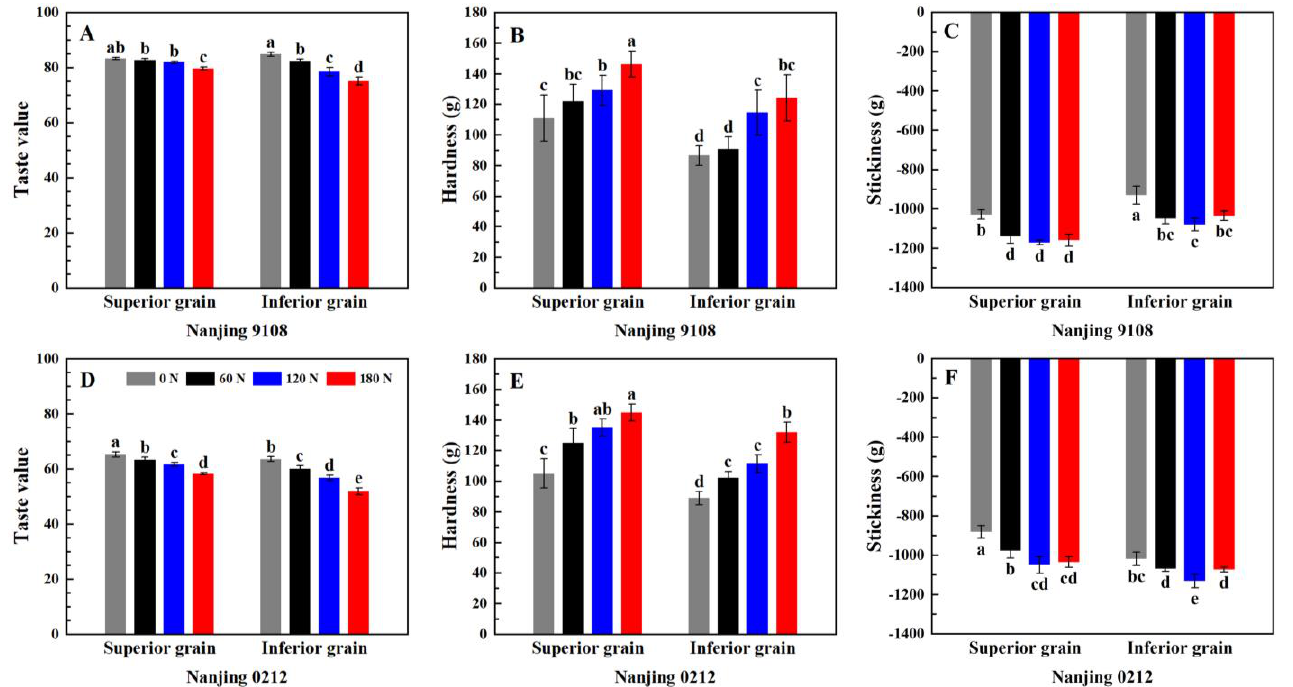
Figure 5. Taste value ( A , D ), hardness ( B , E ) and stickiness ( C , F ) of superior and inferior grains of japonica rice under different PNF treatments. Values with different letters are significantly different ( p < 0.05).